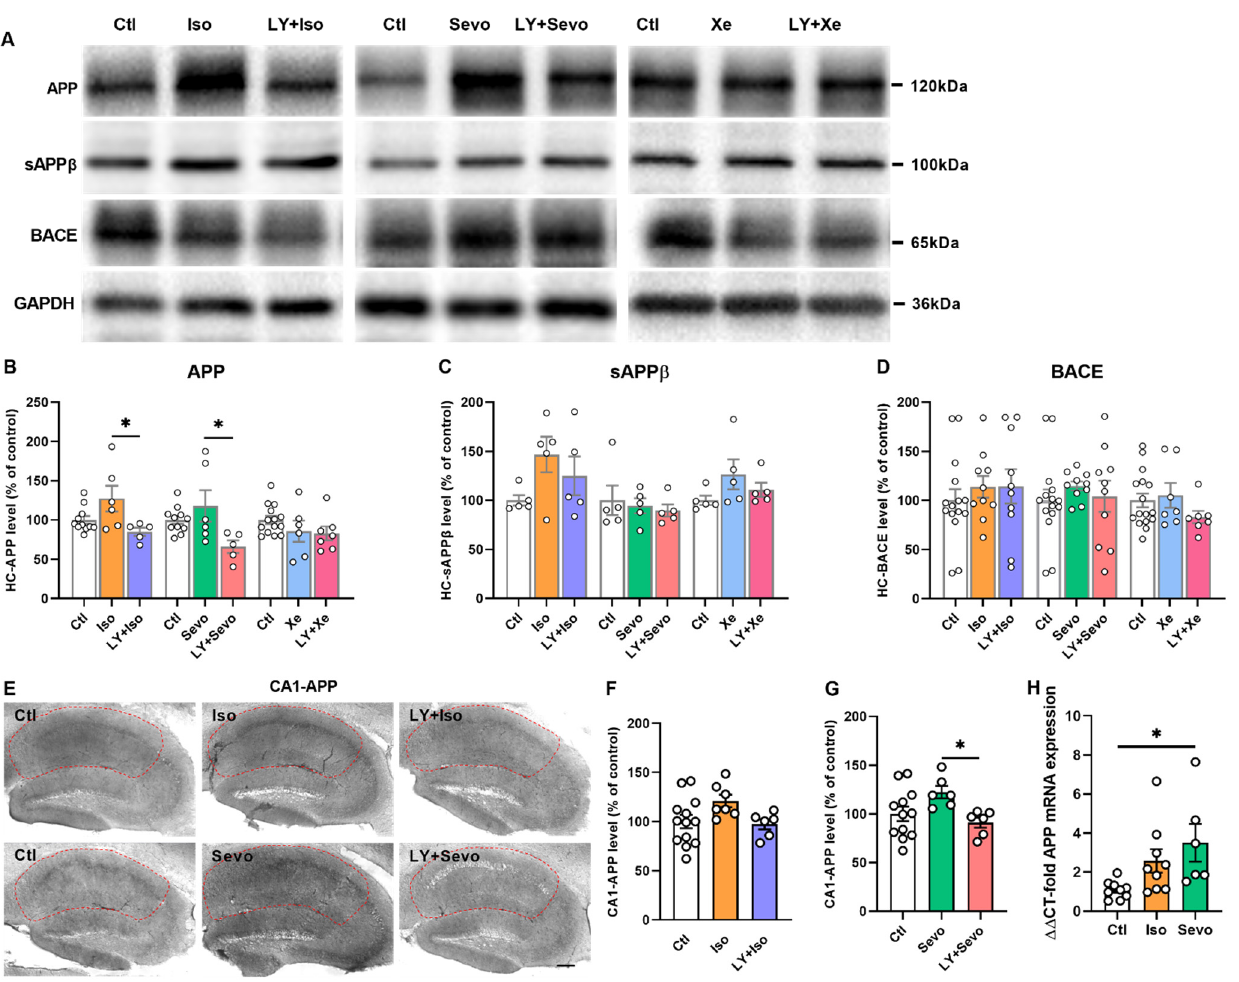
Figure 6. Alteration of hippocampal APP processing-related molecules. ( A ) Representative Western blot images. ( B – D ) Normalized protein levels. ( B ) LY + iso and LY + sevo reduced APP levels in comparison with iso or sevo group, respectively ( B , iso vs. LY + iso: p = 0.0238; sevo vs. LY + sevo: p = 0.0225). ( C , D ) sAPP β and BACE levels between groups. ( E – G ) APP levels in the CA1 region. LY + sevo reduced APP levels compared with the sevo group ( G , p = 0.0421). One-way ANOVA followed by Tukey’s test. ( H ) Iso trended to enhance hippocampal mRNA levels of APP. Sevo increased mRNA levels of APP in the hippocampus ( p = 0.0197). Data are shown as mean ± SEM. Dots repre- sent the number of animals. Detailed statistics are provided in the Table S1. * p < 0.05. APP: amyloid precursor protein, BACE: β -site APP-cleaving enzyme, ctl: control, GAPDH: glyceraldehyde 3-phos- phate dehydrogenase, iso: isoflurane, LY: LY2886721, sAPP β : soluble ectodomain APP β , sevo: sevoflurane, Xe: xenon. Western blot and immunohistochemistry procedures were performed to ensure that LY alone did not affect APP levels in the whole or the subregions of the hippocampus (Figure S1e–g). APP is also a type of cell adhesion molecule supporting the maintenance of dendritic spines and synaptic plasticity [14,27]. Interestingly, we found that APP and nectin-3 were partly colocalized in the hippocampus (Figure S4). We further tested the expression pro- files of nectin-3 and APP in the stratum oriens (SO), stratum pyramidale (SP), and stratum lacunosum-moleculare (SLM) layers in the CA1 region (Figure S4e, ctl [0.19 ± 0.01], n = 6; LY + sevo [0.15 ± 0.01], n = 6; p = 0.0104, post hoc with Tukey’s test of one-way ANOVA ). 2.7. Iso, Sevo, and Xe Markedly Abolished LTP Respectively